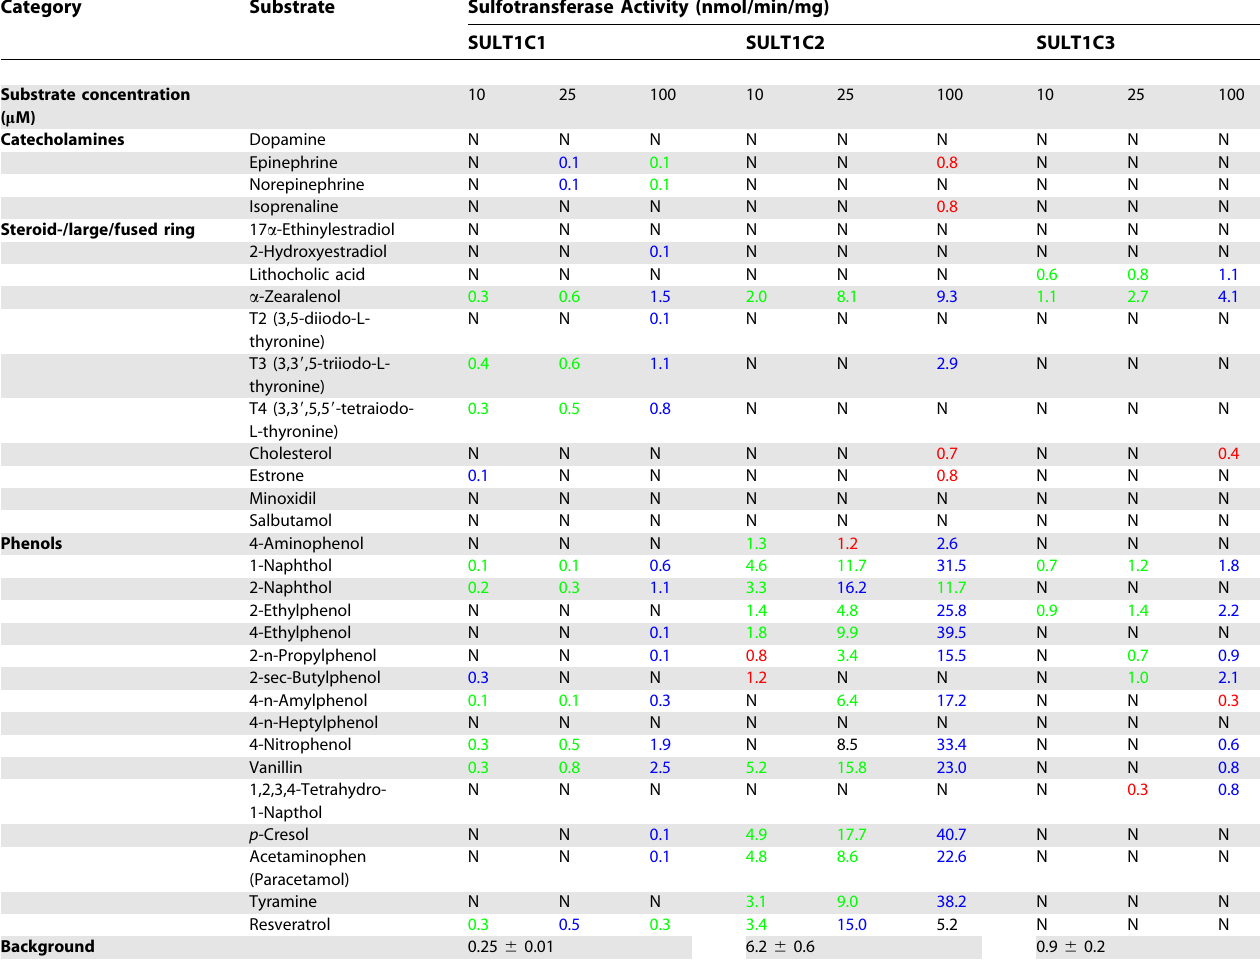
Table 2. Sulfotransferase Activity Screen of hSULTs Category